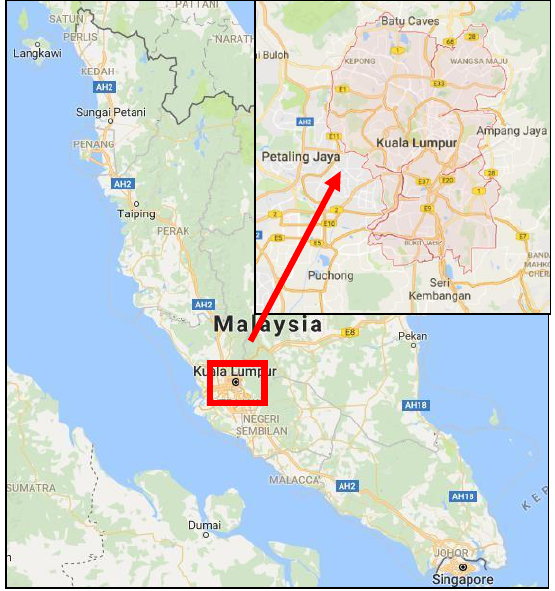
Figure 1. The study area (Adapted: Google Map, 2017)